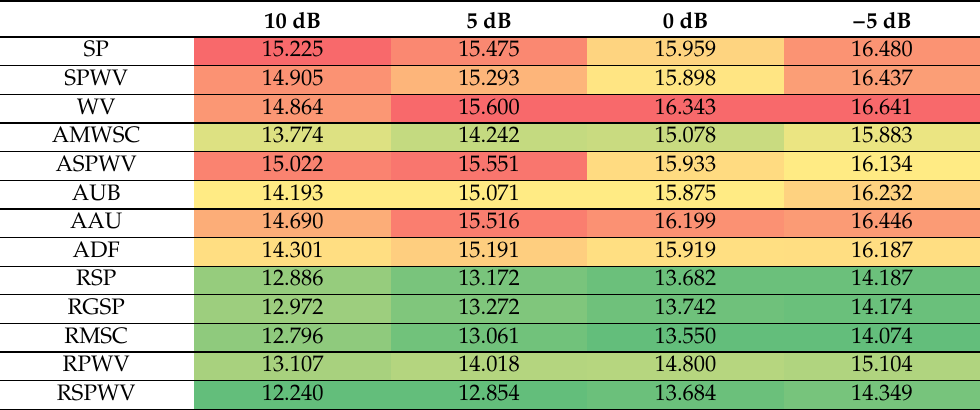
Table 2. TFR Rényi entropy for a noisy mono-component linear FM signal for different SNR levels (averaged over 100 noise realizations), cell colors range from green for the best result to red for the worst result in each column